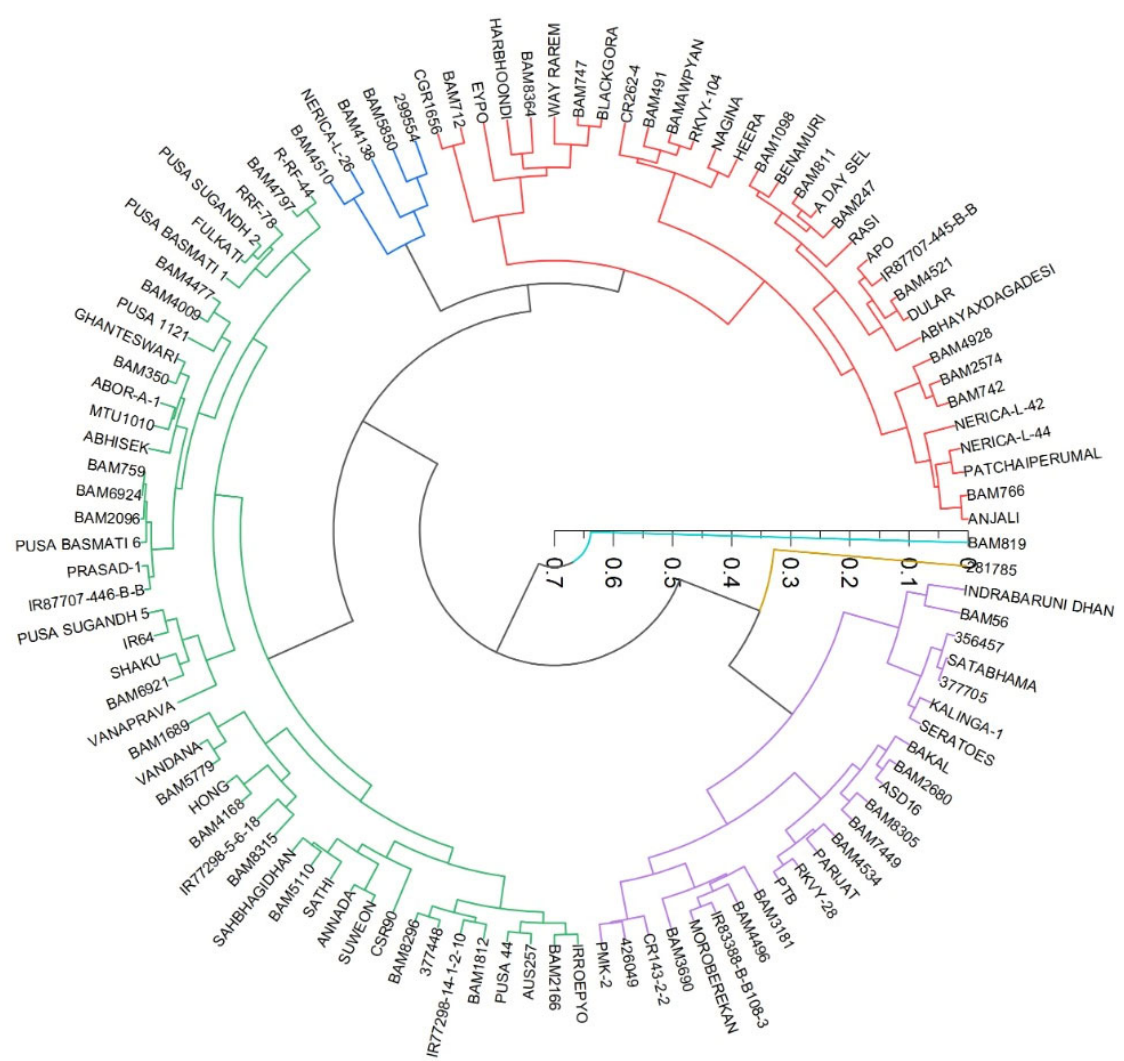
Figure 14. Grouping of genotypes based on the number of leaves, and the number of leaves that emerged between the initial days of induced stress and peak drought stress .